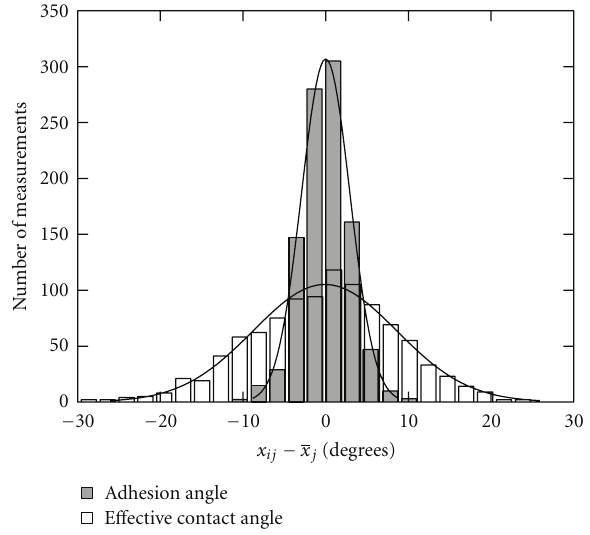
Figure 4: A histogram of the di ff erences between the measured angles, x ij , measured on the sample of j max = 200 intervesicle contacts by i max = 5 raters and the average value of all raters for the given angle, x j . Empty (white) bars represent measurements of the e ff ective contact angle, the conventional measure of adhesion, and solid (gray) bars represent the measures of the adhesion angle, the new measure of adhesion proposed in this work. Solid lines represent best fit of the normal distribution.